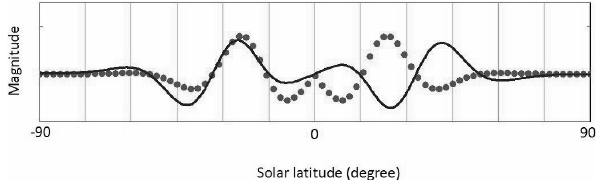
Fig. 3. Simulations of poloidal magnetic field for the dipole (solid line with D 1 = − 10 4 , V =0.2) and quadruple (dotted line with D 2 = − 10 4 , v = − 0.2) magnetic sources reproducing the latitudinal SBMF distributions for cycle